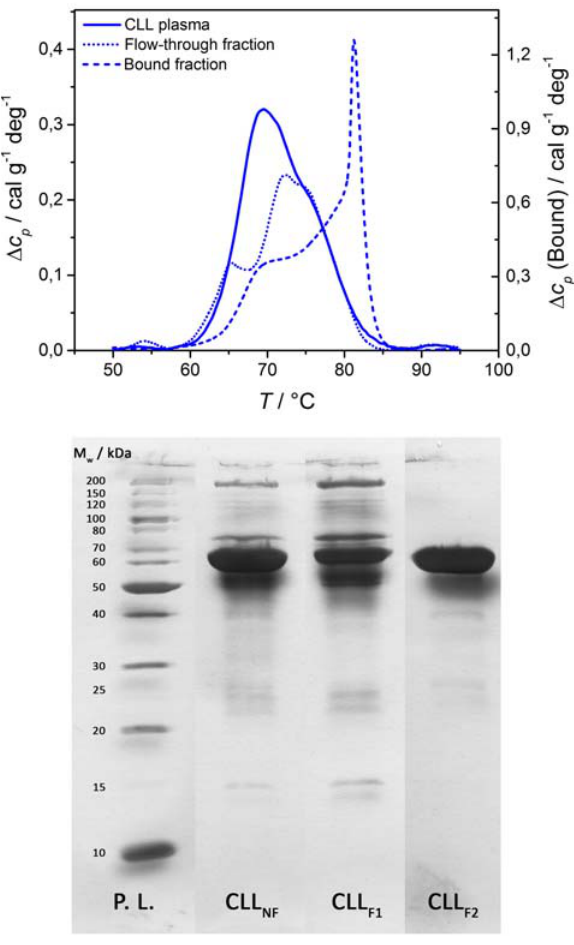
Figure 2. Thermograms of blood plasma from an individual with CLL (top). DSC thermogram of a non-fractionated blood plasma sample (full line) is compared to thermograms of flow-through (dotted line) and bound fraction (dashed line) obtained from HPLC axis corresponds to the bound fraction. fractionation. The right Δ C p SDS-PAGE of blood plasma from an individual with CLL (bot- tom); P. L. – protein library, CLL – non-fractionated blood pla- NF sma (1 mg/mL), CLL – flow-through fraction (1 mg/mL), CLL F1 F2 – bound fraction (0.8